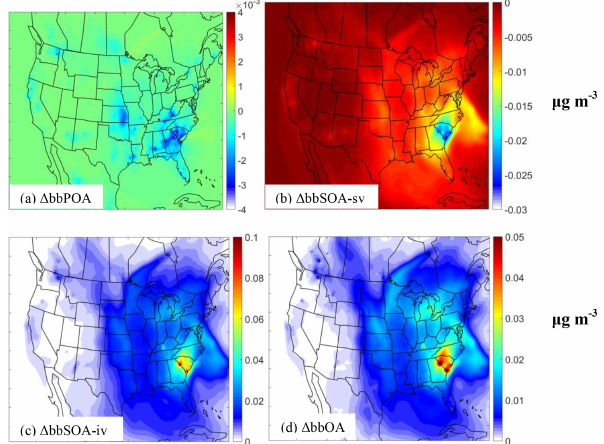
Figure 8. Average predicted increase (µgm − 3 ) in the predictions of the base PMCAMx-SR scheme when the volatility distribution of Ciarelli et al. (2017a, b) is used for the biomass burning emissions compared to the predictions with the default values for ground-level PM 2 . 5 (a) bbPOA, (b) bbSOA-sv, (c) bbSOA-iv, and (d) bbOA dur- ing April 2008. Positive values indicate that the PMCAMx-SR base scheme with the volatility distribution of Ciarelli et al. (2017a, b) predicts higher concentrations.